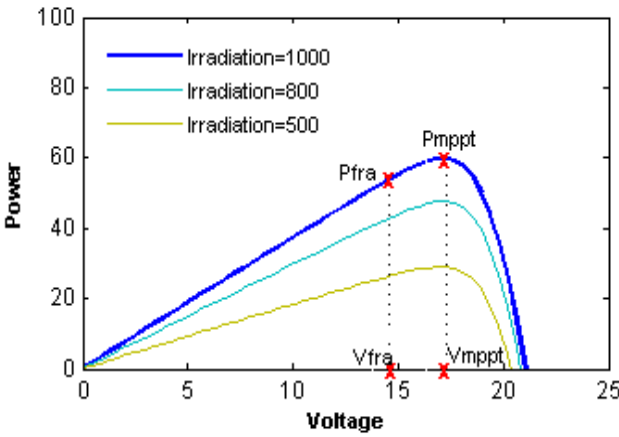
Figure 4. The Power-Voltage curve of a typical module (BP MSX 60).